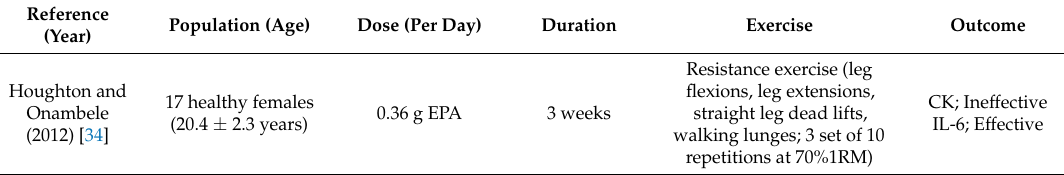
Table 5. Summary of Effects of EPA/DHA supplementation on serum cytokines and muscle damage